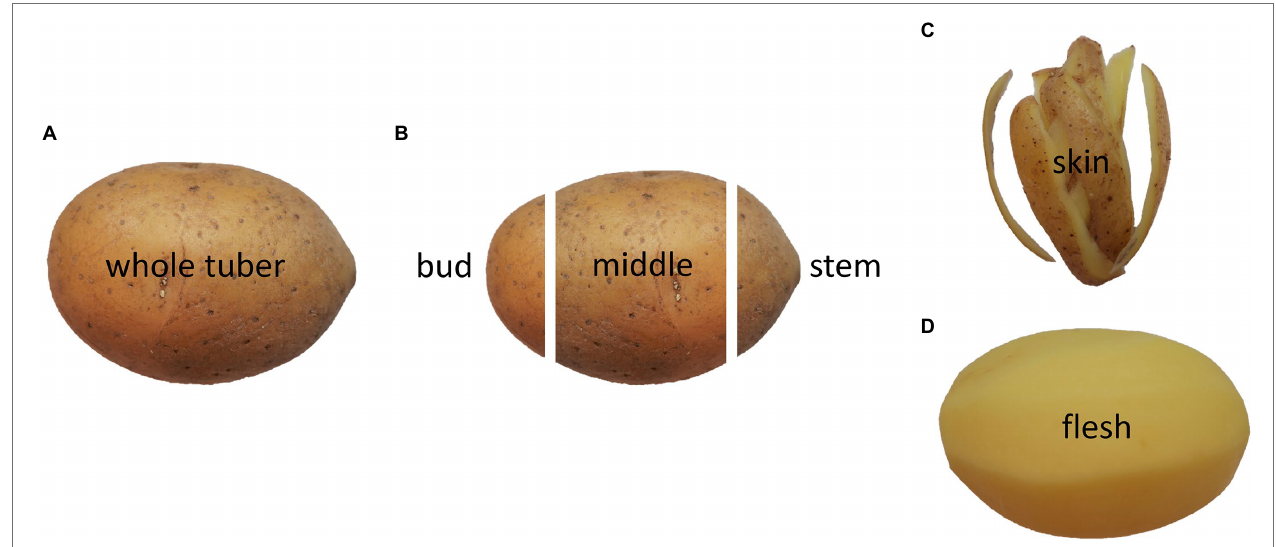
FIGURE 1 | Illustration of tuber parts used for analyses showing whole tuber (A) , bud end, middle part, stem end (B) , skin (C) , and flesh (D)